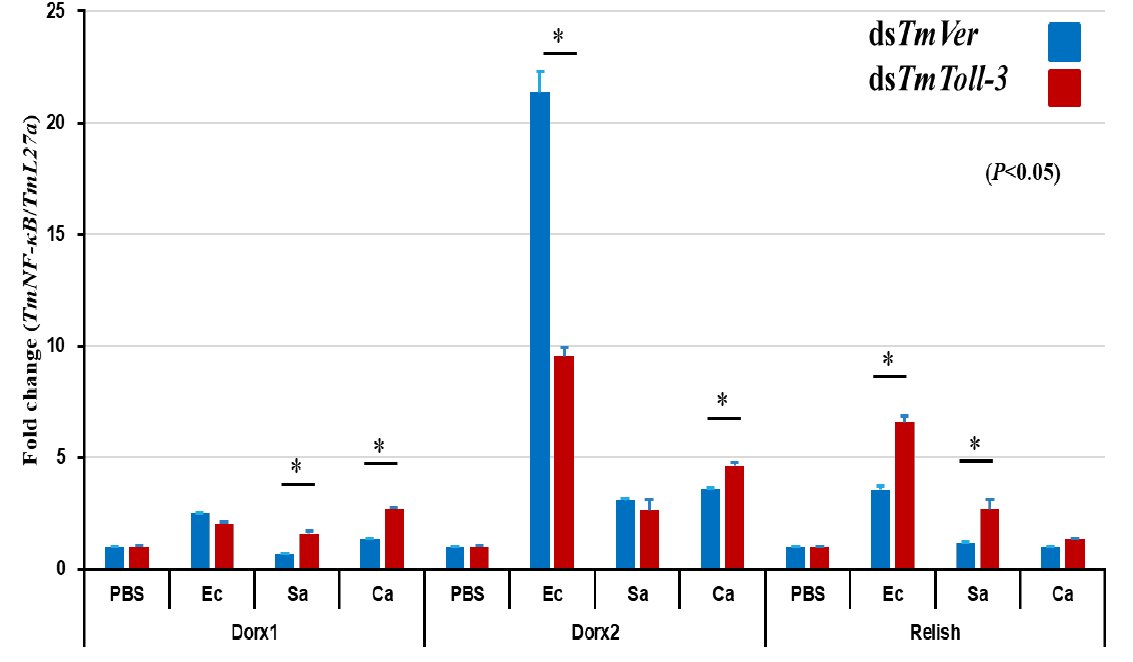
Figure 6. Effect of TmToll-3 gene silencing on NF-kB gene expression. ds TmToll-3 -treated T. molitor larvae were infected with E. coli (Ec), S. aureus (Sa), and C. albicans (Ca); at 24 h post-infection, whole- body mRNA levels of the NF-kB pathway genes TmDorX1 , TmDorX2 , and TmRelish were measured via RT-qPCR. The expression level of TmDorx2 was suppressed following E. coli infection in the whole-body tissues, whereas the level of TmRelish was slightly positively regulated. TmVer dsRNA was assessed as a negative control and T. molitor ribosomal protein ( TmL27a ) was used as an internal control. All experiments were performed in triplicate. The asterisks indicate significant differences between ds TmToll-3 - and ds TmVer -treated groups determined using Student’s t -test ( p < 0.05). Table 1. Sequences of the primers used in this study.